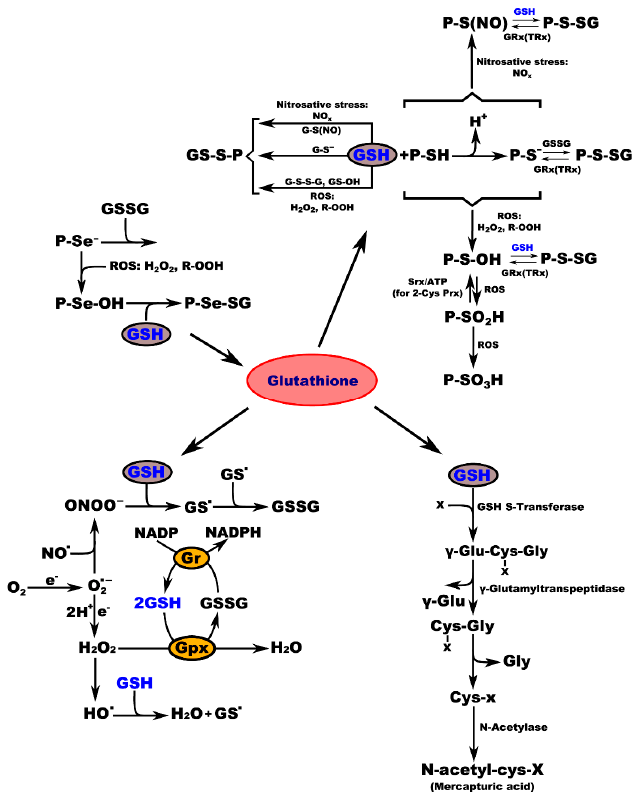
Figure 3. Interconnection of GSH metabolic pathways. P-protein; P-Se − -protein-selenate anion; ROS- reactive oxygen species; H 2 O 2 -hydrogen peroxide; R-OOH-hydroperoxide; P-Se-OH-protein-sele- nenic acid; GSH-glutathione, P-Se-SG-protein-selenate; NO x -reactive nitrogen species; G-S(NO)-S- nitroso-glutathione; G-S - -glutathione-thiolate; GSSG-glutathione disulfide (oxidized glutathione); GS-OH - -glutathione sulfenic acid; P-SH-protein sulfhydryl group; H + -proton; P-S − -protein-thiolate anion; P-S(NO)-protein-S-nitroso thiol; P-S-SG-protein-S-glutathione; GRx(TRx)-glutaredoxin (thi- oredoxin); P-S-OH-protein-sulfenic acid; Srx-sulfiredoxin; ATP-adenosine triphosphate; 2-Cys Prx- 2-cysteine peroxiredoxin; P-SO 2 H-protein-sulfinic acid; P-SO 3 H-protein-sulfonic acid; O 2 -oxygen; e . - electron radical; O 2 − -superoxide radical; NO-nitric oxide radical; ONOO − -peroxynitrite; GS-gluta- thione radical; e − -electron; Gr-glutathione reductase; GPx-glutathione peroxidase; NADP-nicotina- mide adenine dinucleotide; NADPH-nicotinamide adenine dinucleotide phosphate; H 2 O-water; HO − -hydroxyl radical; x-compound with an electrophilic center that can be conjugated to GSH by GSH S-transferase; γ -Glu-Cys-x-Gly- γ -glutamate-cysteine-x-glycine; γ -Glu- γ -glutamic acid; Cys-x- Gly-cysteine-x-glycine; Gly-glycine; Cys-x-cysteine-x; N-acetyl-cys-x-mercapturic acid-x.